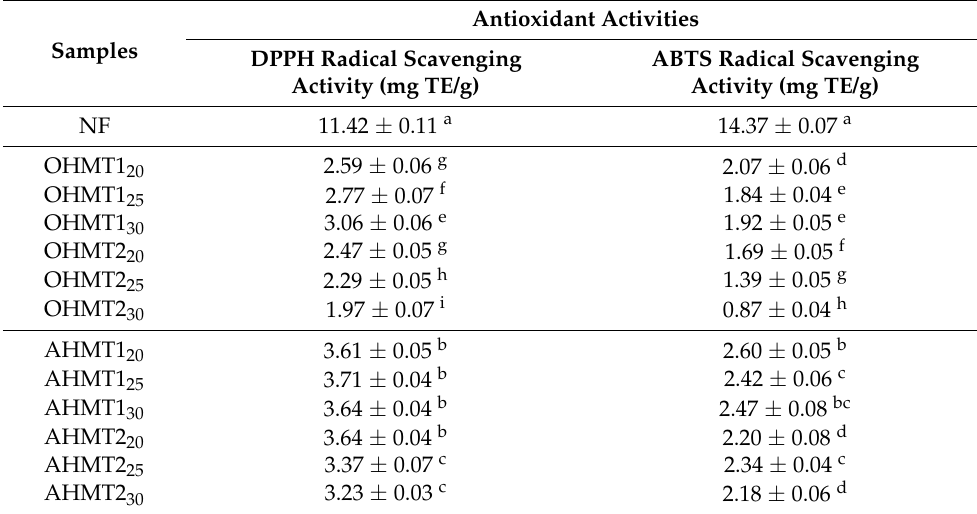
Table 4. Antioxidant activities of native and HMT-treated purple rice flour samples.